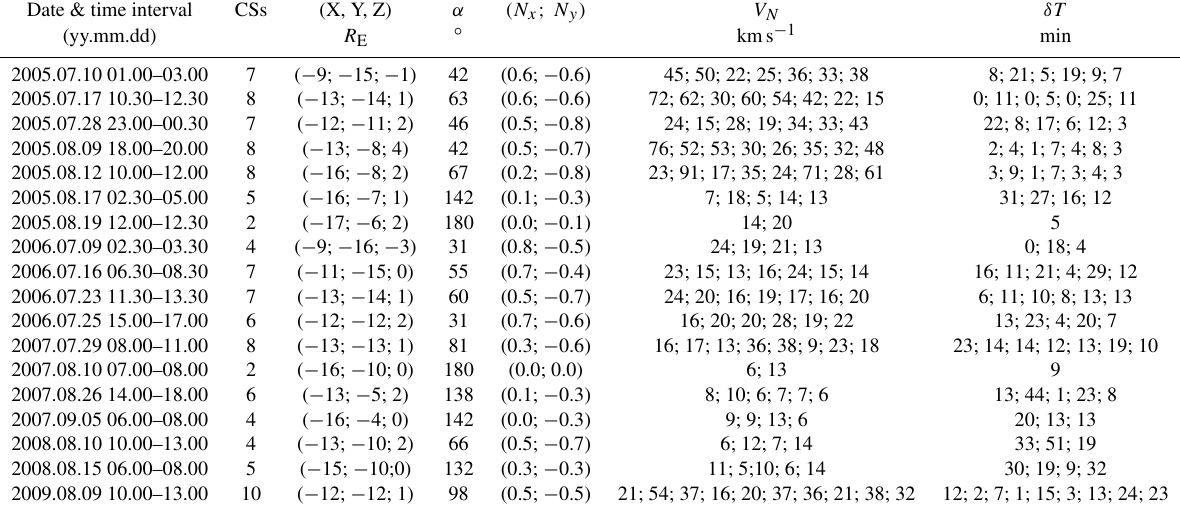
Table 1. CS crossing characteristics: date and crossing time interval, number of CS crossings within a series, coordinates of the first CS crossing in GSM system (averaged from four spacecraft), angle α between two successive normal vectors (average value for entire series), N x and N y components of the normal vector, velocity V N for each crossing, and time delays δT between CS crossings (averaged from four